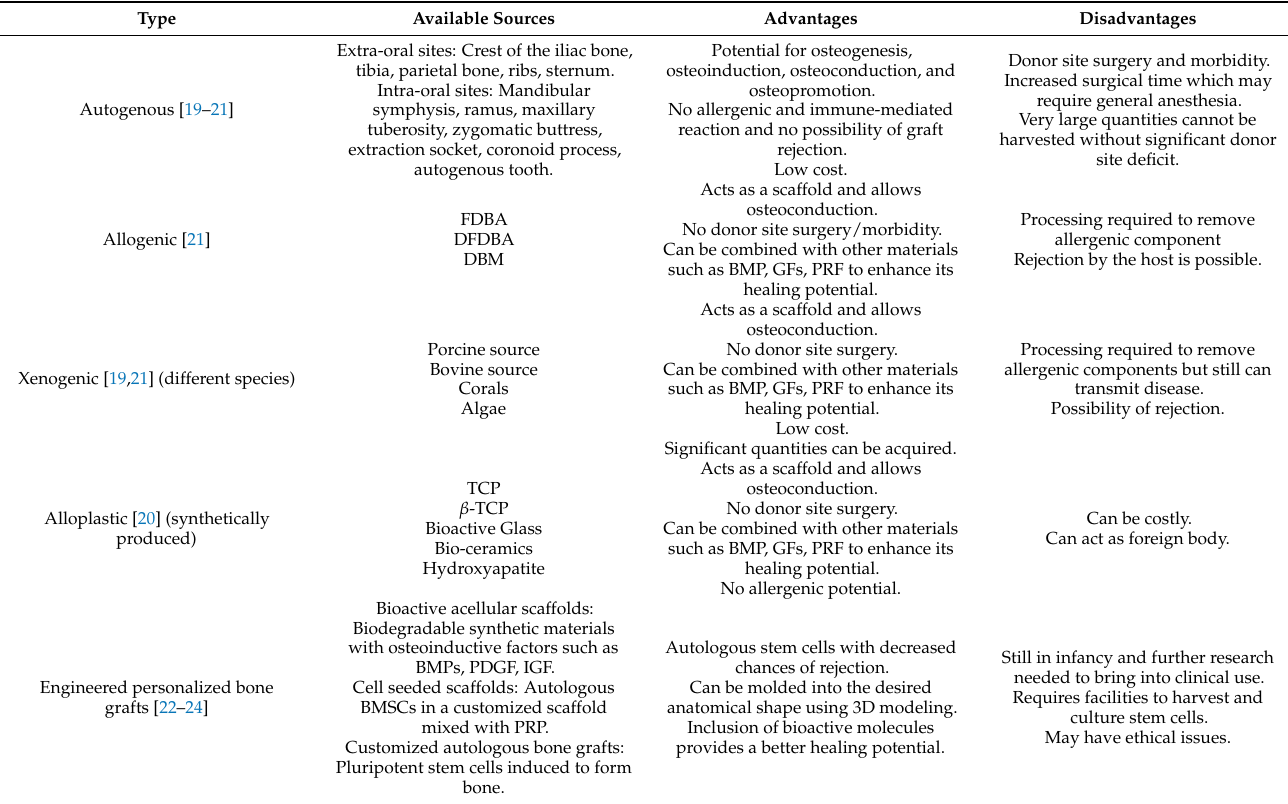
Table 1. Different sources of graft with their individual